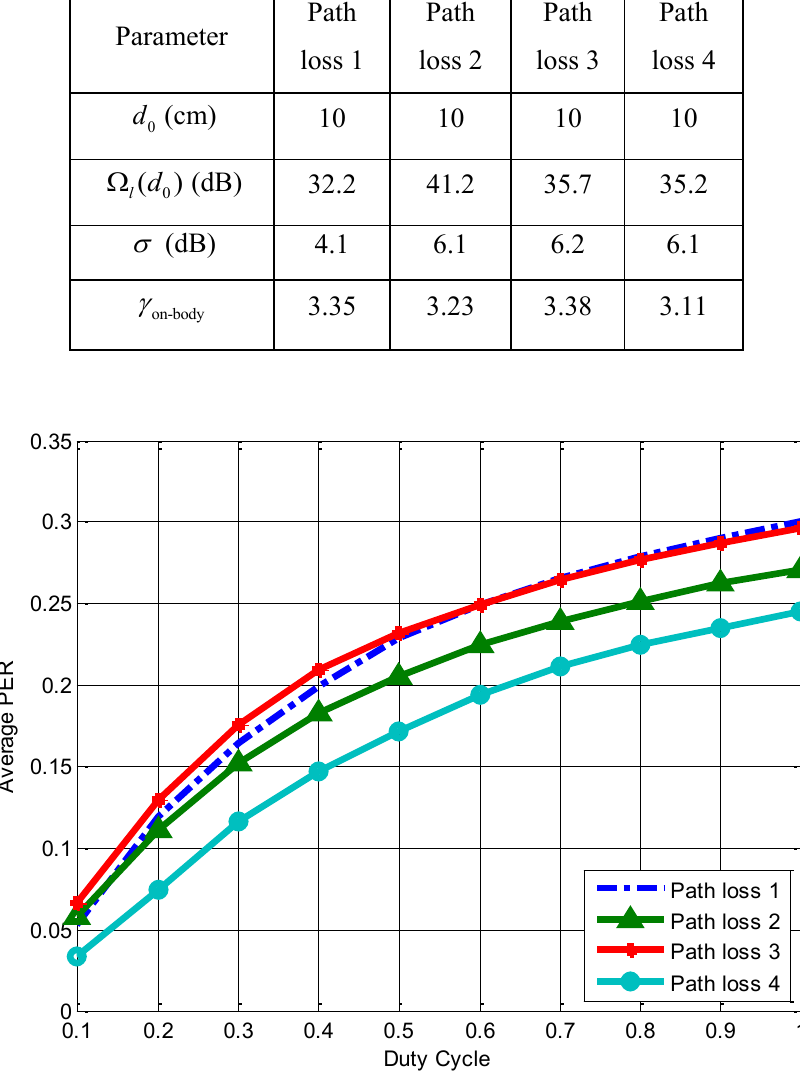
Figure 5. Average PER for different on-body path loss